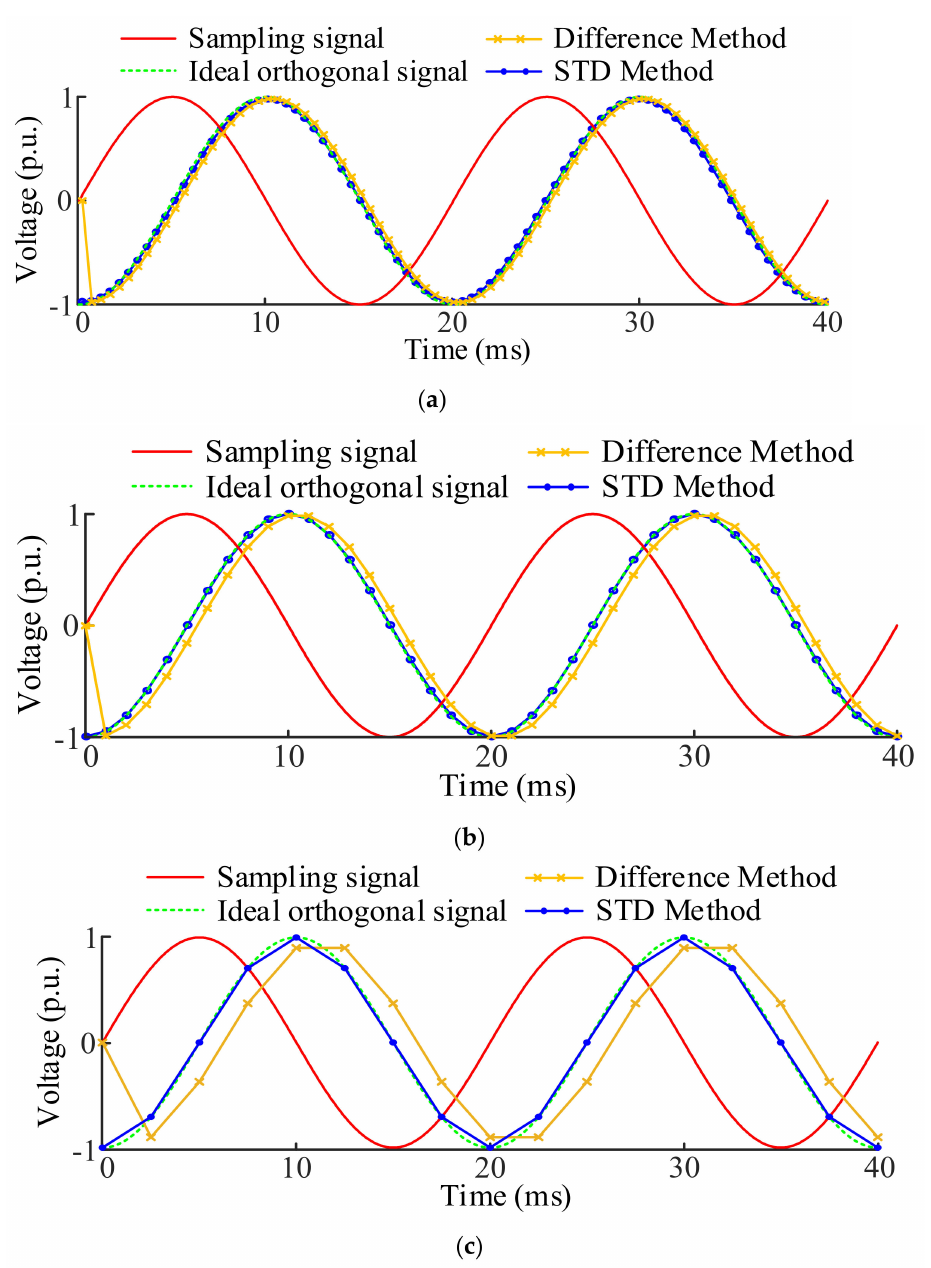
Figure 3. Effect of quadrature signal construction algorithm with different sampling periods ( a ) T s = 0.5 ms; ( b ) T s = 1 ms; ( c ) T s = 2.5